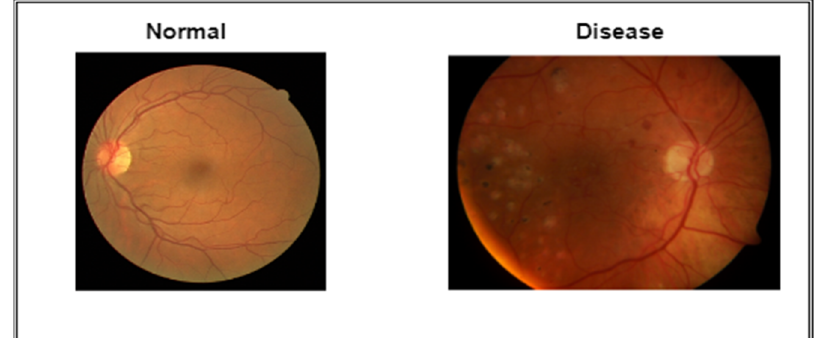
Figure 10. Visual representation of the hypertensive retinopathy images.